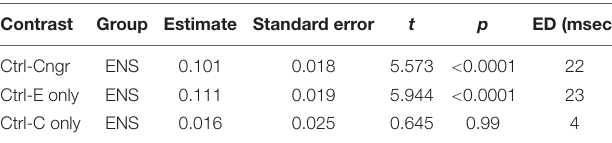
TABLE 8 | Results of post hoc , within-group tests of RTs for congruent, English-only, and Chinese-only items relative to the control items for English